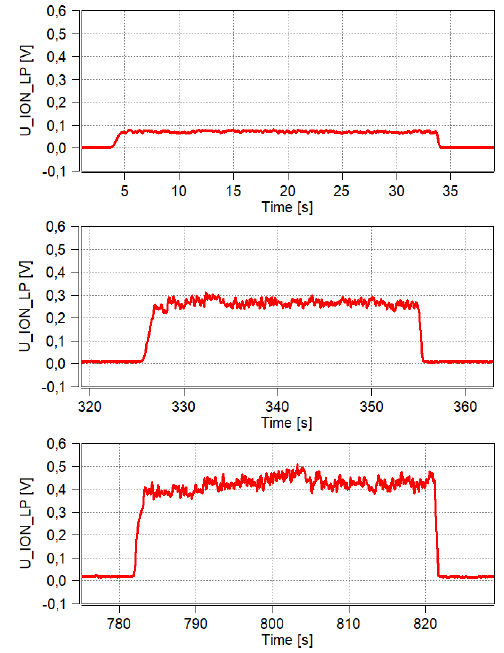
Fig. 6. Ionization waveforms with system voltage of (from the top): 50 V, 200 V and 388 V (spark plug No.